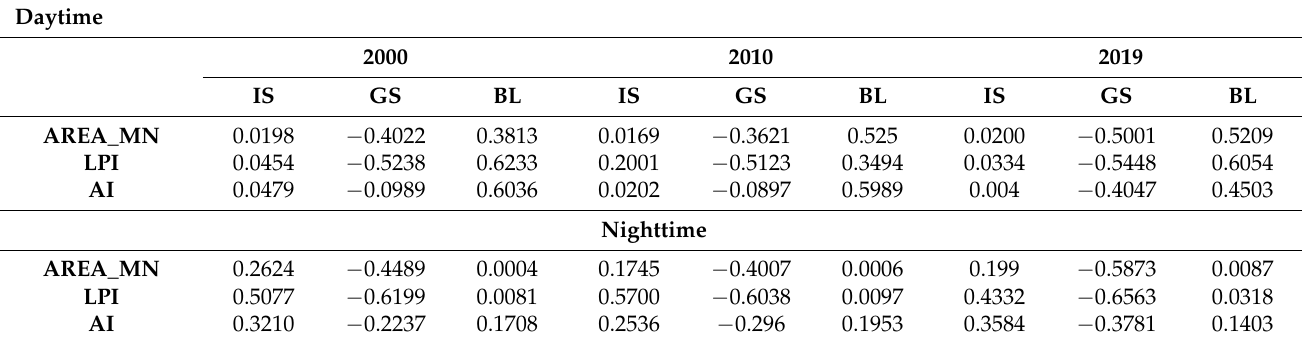
Table 3. Correlation results (r values) between three spatial metrics and mean